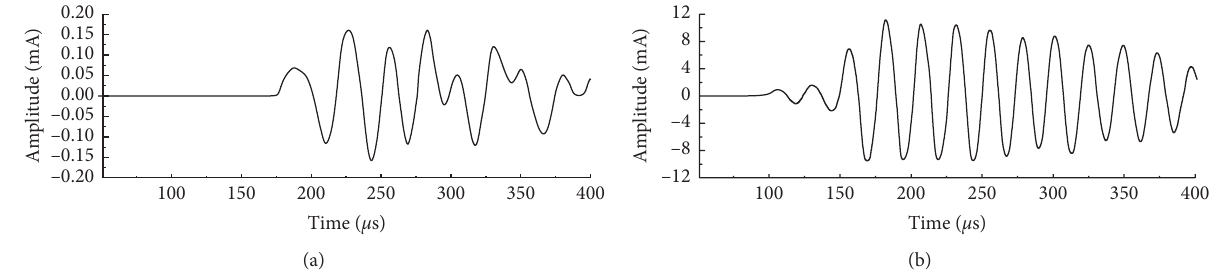
Figure 8: The waveform obtained in BDZ (a) and out of BDZ